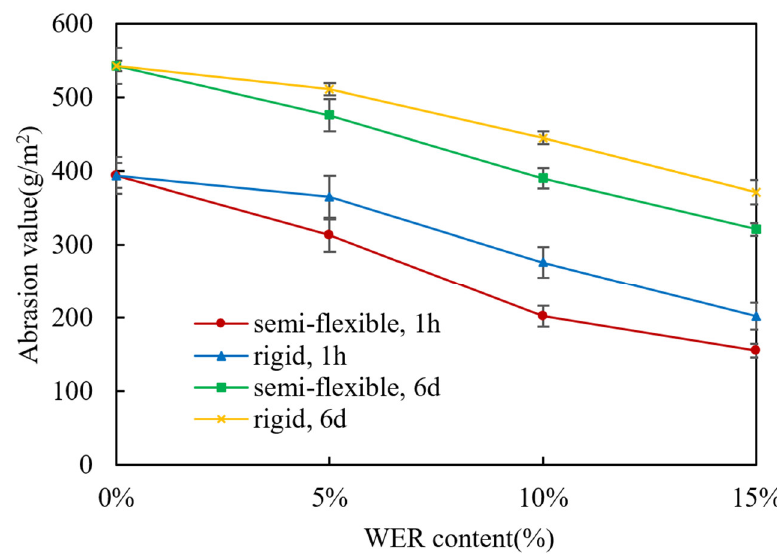
Figure 21. Wet wheel wear resistance test result.